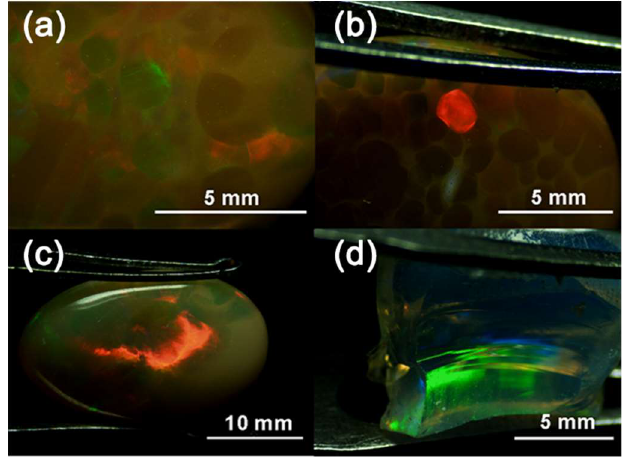
Figure 6. Different shaped play-of-colour patches in Ethiopian opals. ( a ) Silk-like (Opal-05); ( b ) Flaky (Opal-04); ( c ) Flaming (Opal-01); ( d ) Band-shaped (Opal-08).